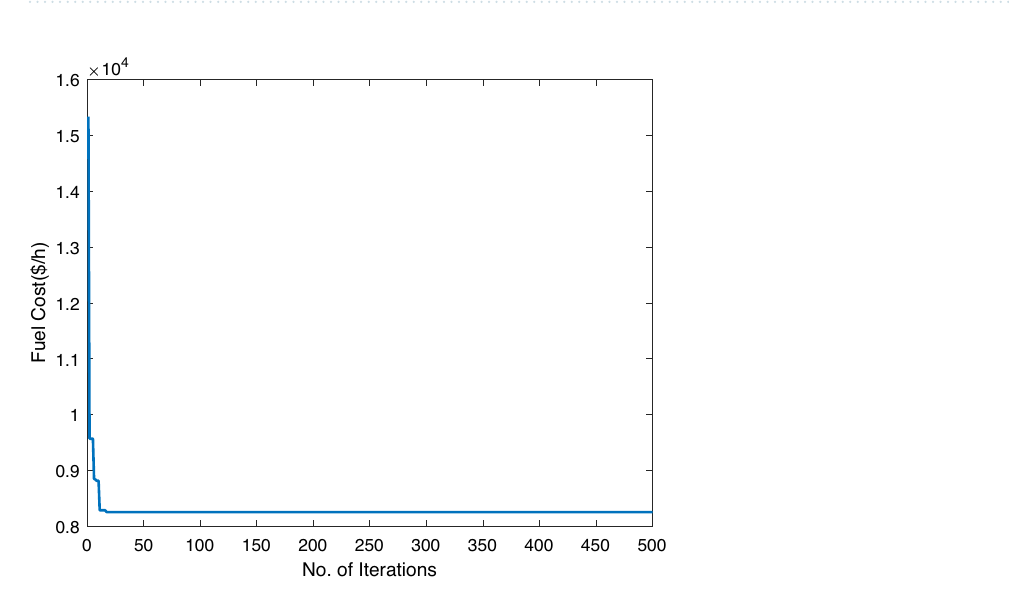
Figure 15. ABWO performance for case study-V.